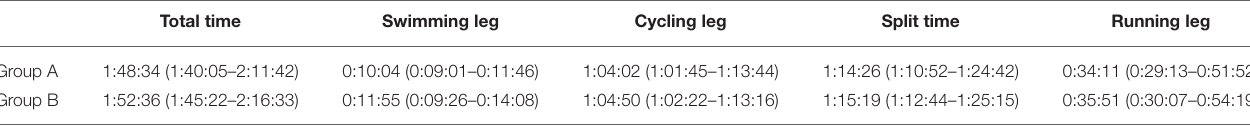
TABLE 1 | Total time, split time and each leg